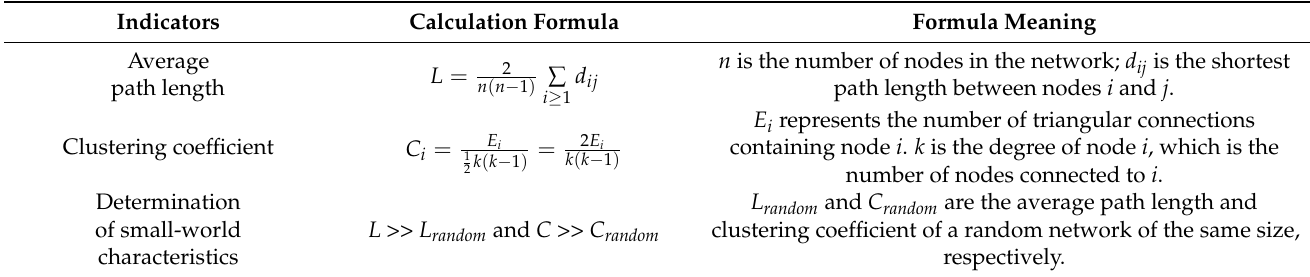
Table 1. Indicators for determining the small-world characteristics of complex